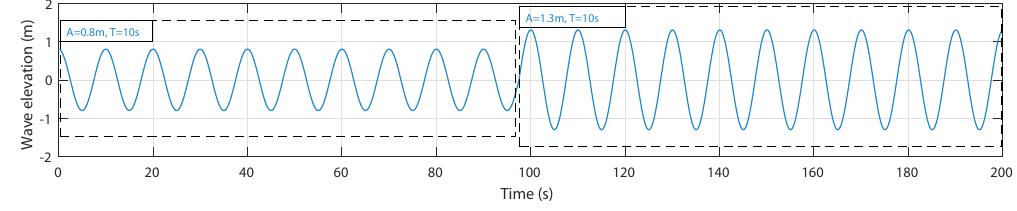
Figure 19. Considered wave input to the implemented OWC model.